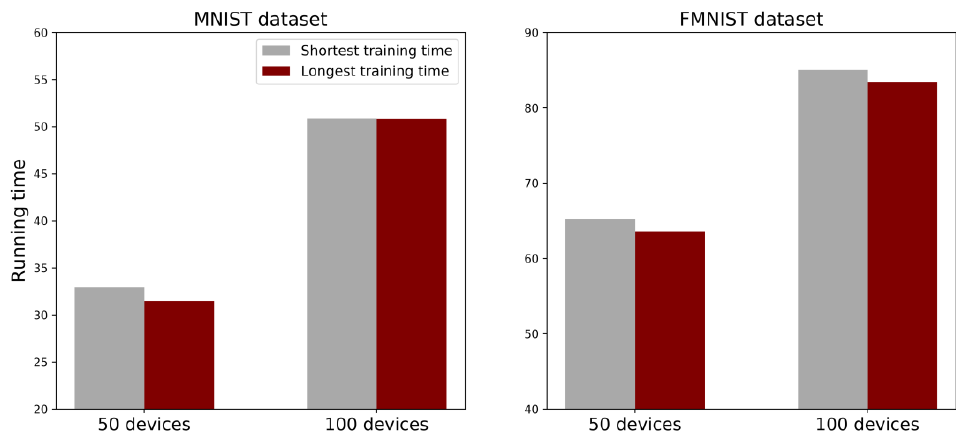
Figure 9. Average running time for FL using the MNIST and FMNIST datasets in environments with 50 and 100 devices in ten APs, for 100 communication rounds. The label ‘Longest training time’, as the proposed method, shows the system in which the AP with the longest training time is determined as the P-AP. The label ‘Shortest training time’, as the comparison, shows the system in which the AP with the shortest training time is determined as the P-AP.